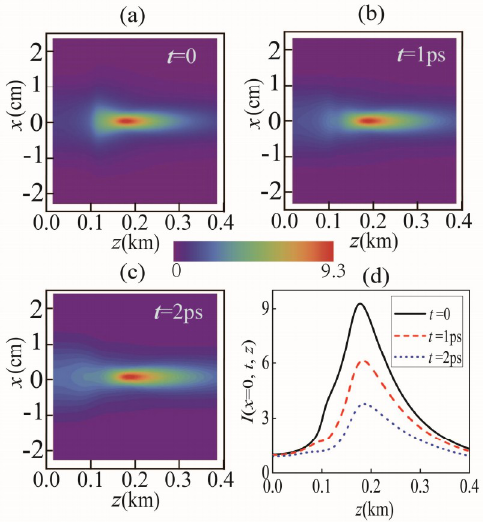
Figure 1. Evolution of normalized spatial-temporal intensity I ( x , t , z ) of PCP beams with rect weight function with different values of time t : ( a ) t = 0, ( b ) t = 1 ps and ( c ) t = 2 ps in the x - z plane. ( d ) On-axis normalized spatial-temporal intensity versus propagation distance z .